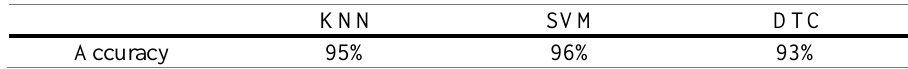
Table 2. Accuracy values of